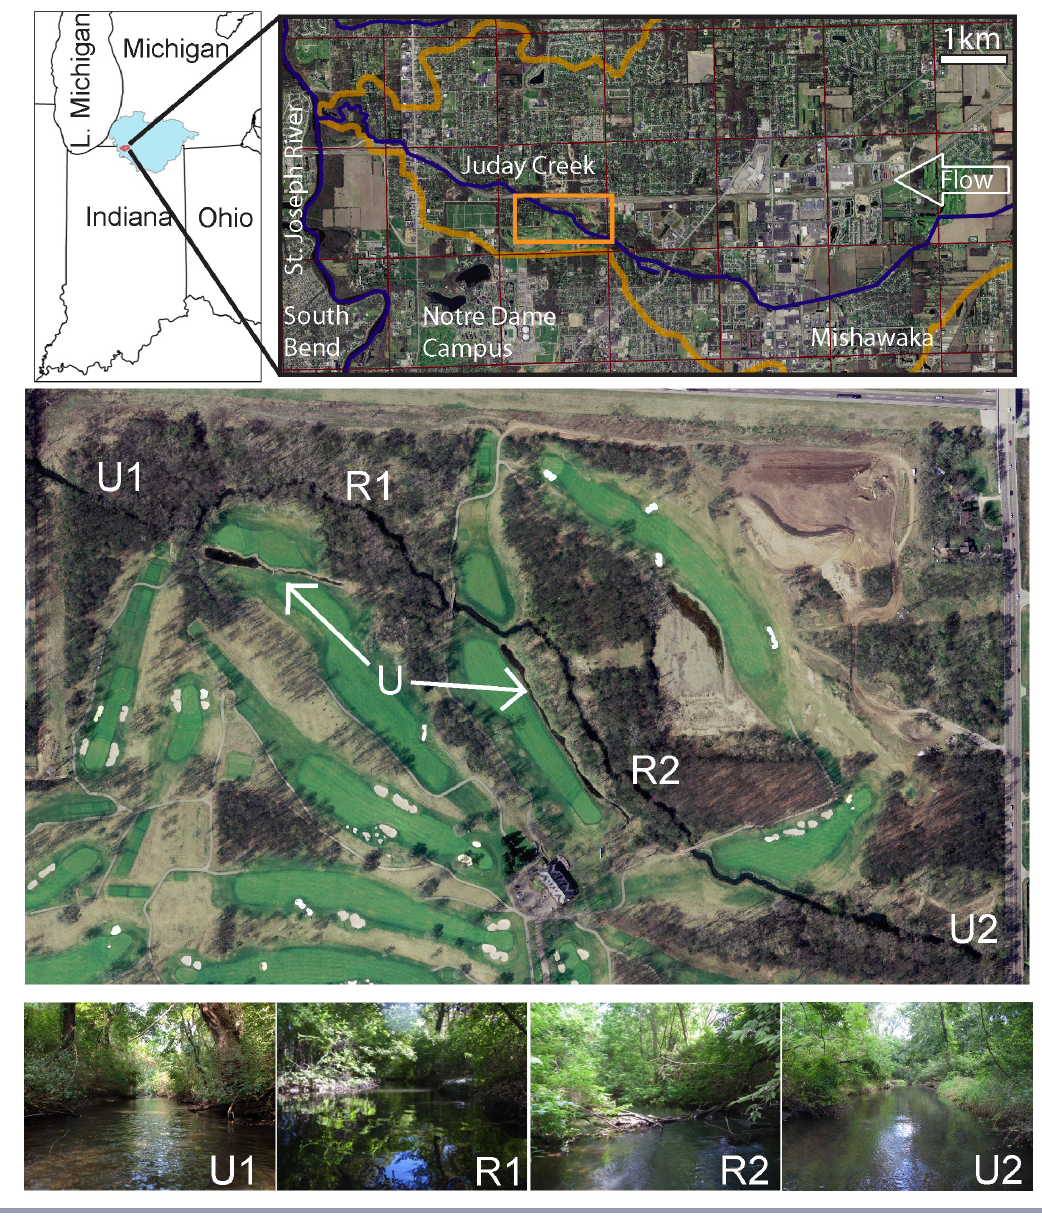
Fig. 1 . Juday Creek is a groundwater-fed, 3rd-order tributary within the St. Joseph River watershed (highlighted in light blue), which flows into Lake Michigan; the 19-km stream drains an area of 98 km 2 in northwestern Indiana (41°42'N, 86°13'W; elevation = 206 m). The unrestored reach, U1, was located downstream of restored reaches, R1 and R2, while the unrestored reach, U2, was located upstream of the restored reaches, all within a 1.2-km stream reach in Township 38N R3E, section 30 bordered by Ironwood Road on the east and Interstate 80/90 on the north. The stream was relocated from a channelized reach (U) to minimize the impact of golf course fairways on stream